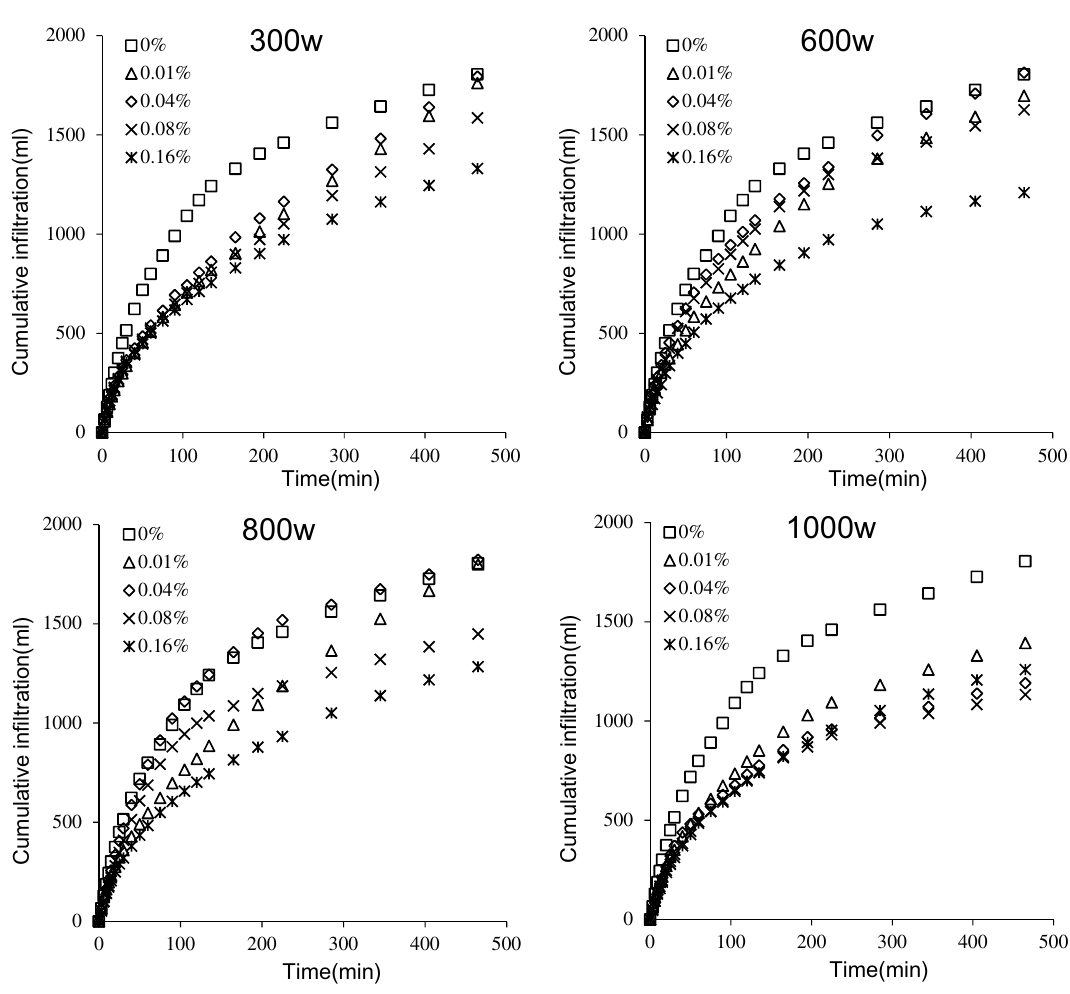
Figure 5. Cumulative infiltration of iron tailings for four molecular weight (300w, 600w, 800w and 1000w) and five mass concentration (0%, 0.01%, 0.04%, 0.08% and 0.16%) of